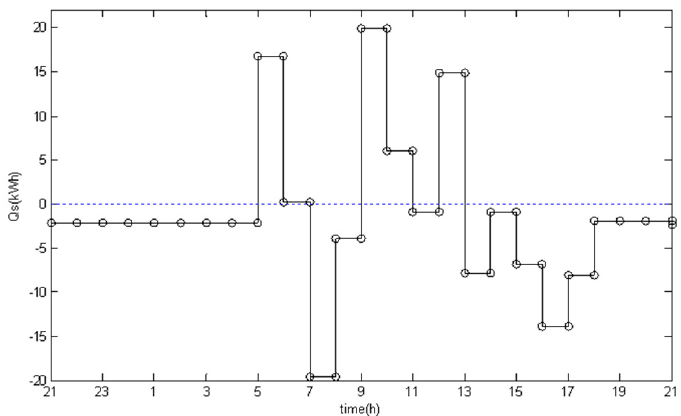
Figure 15. Output heat of the thermal storage.